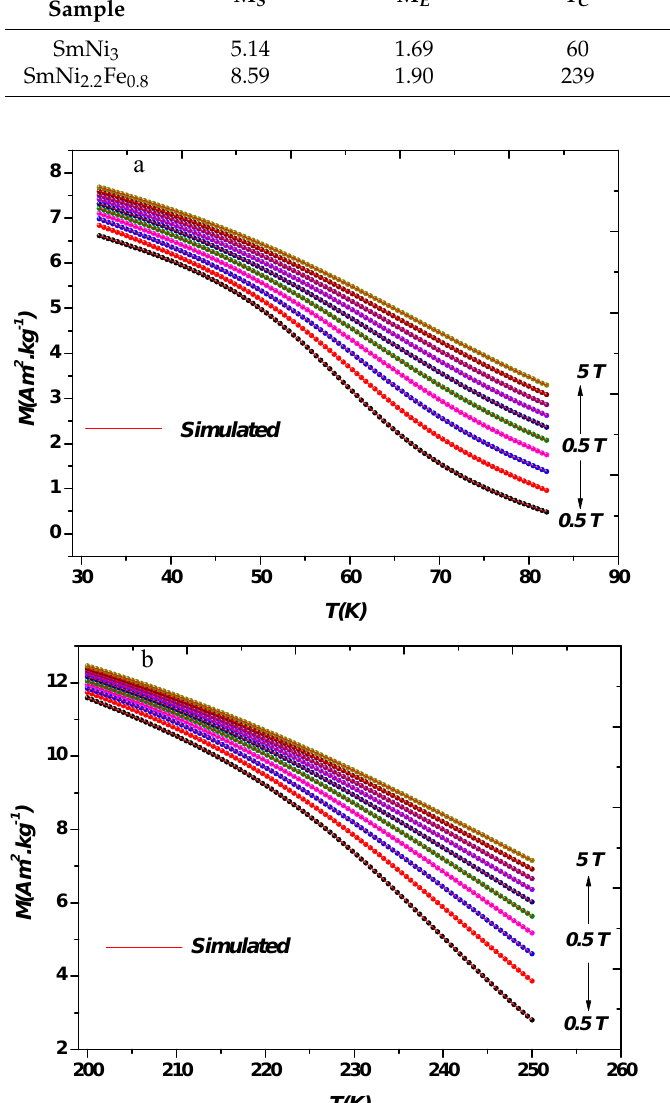
Figure 9. Magnetization vs. temperature for SmNi 3 ( a ) and SmNi 2.2 Fe 0.8 ( b ) under several magnetic